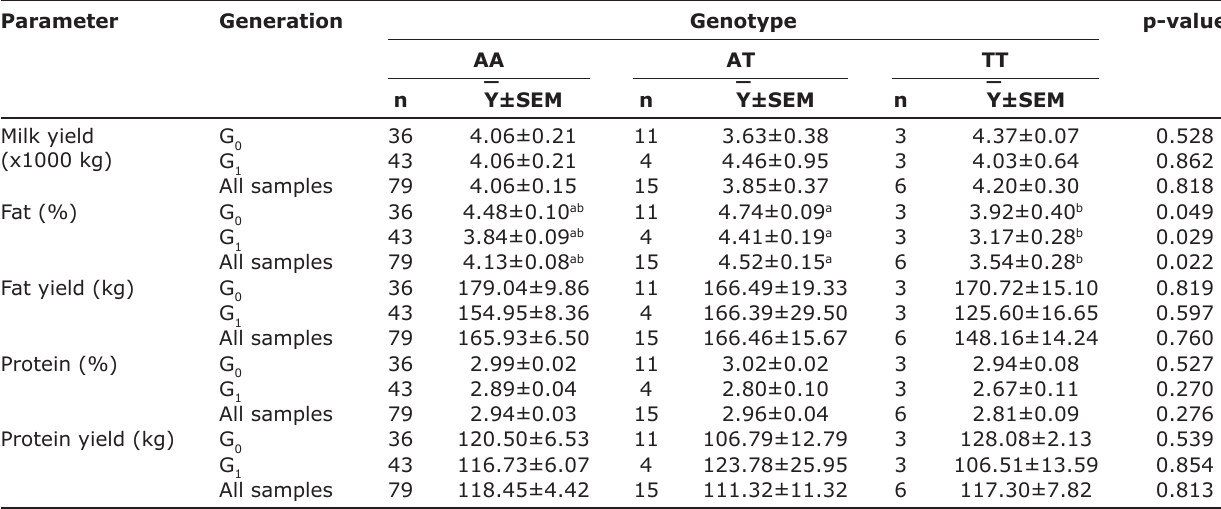
Table-5: Association of FTO g. 1367A>T with milk traits. Parameter